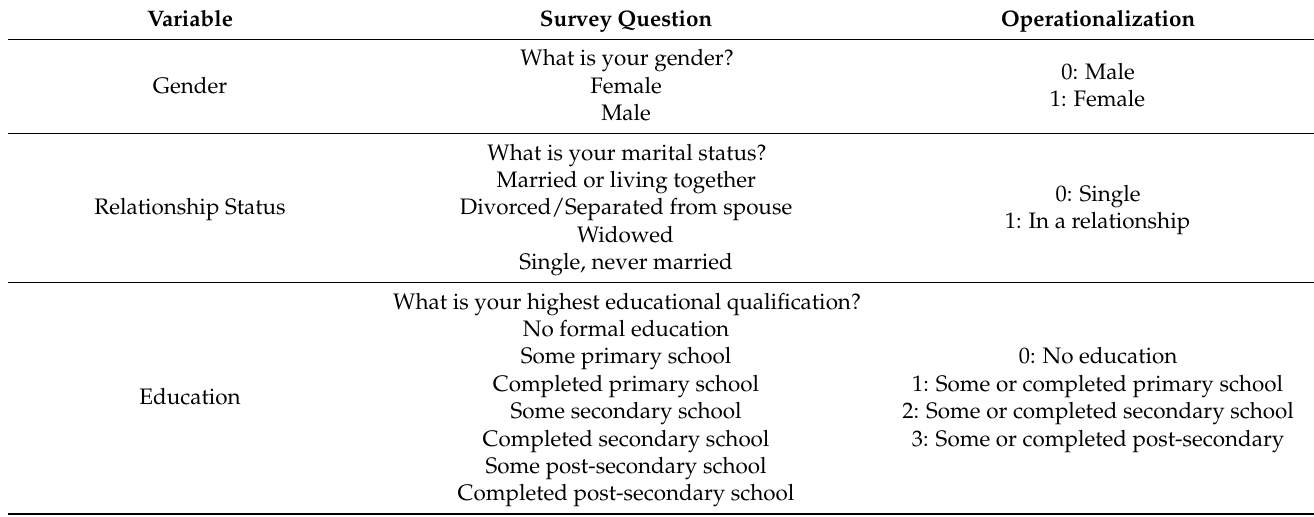
Table 1. Variable